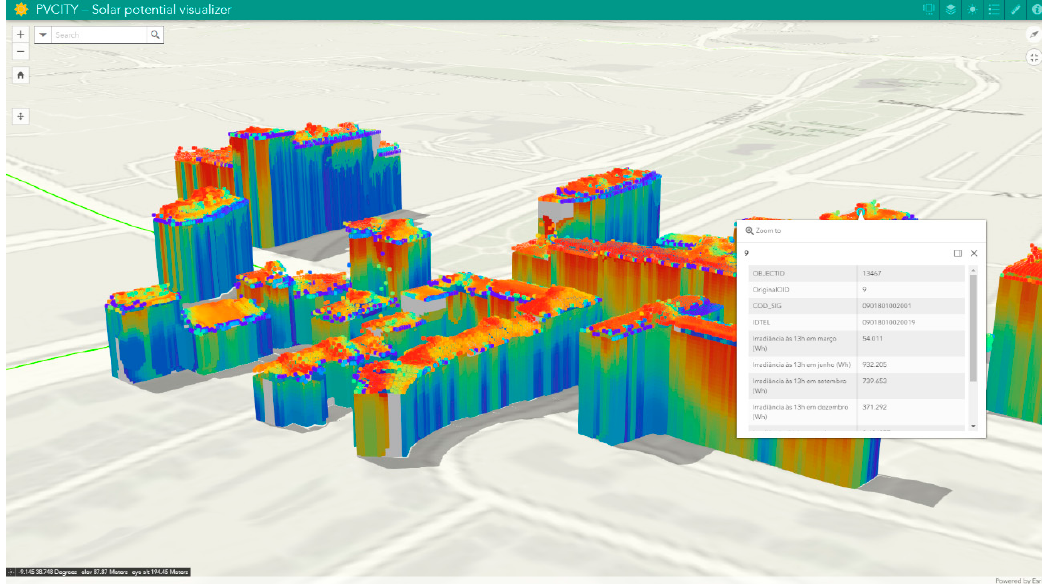
Figure 5. Example of WebGIS viewer output.